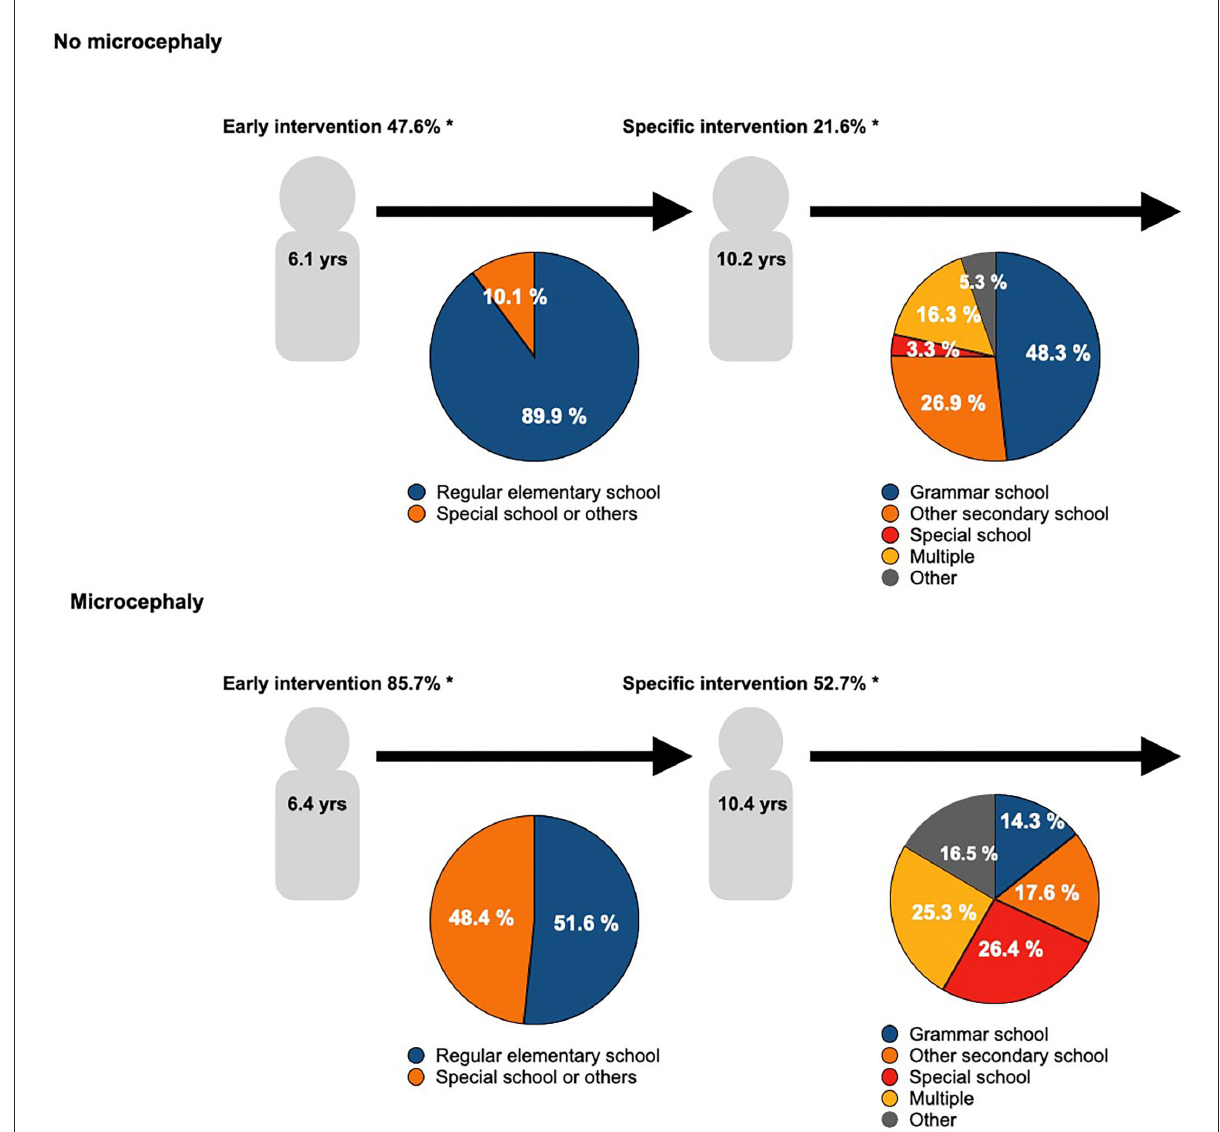
FIGURE4 Educational development in CHD patients. The graph visualizes the school career of CHD patients with or without microcephaly. The median age of school enrollment and the first change of school are given in the figures. The distribution of different kinds of primary schools in the left pie chart is represented, and the pie chart on the right represents the different kinds of secondary schools. Further, the usage of early and/ or specific interventions to support the school careers is given. Differences in the kind of school are significant < 0.001; additionally * denotes a significant difference compared to non-microcephalic patients, p < 0.001, and + denotes p <